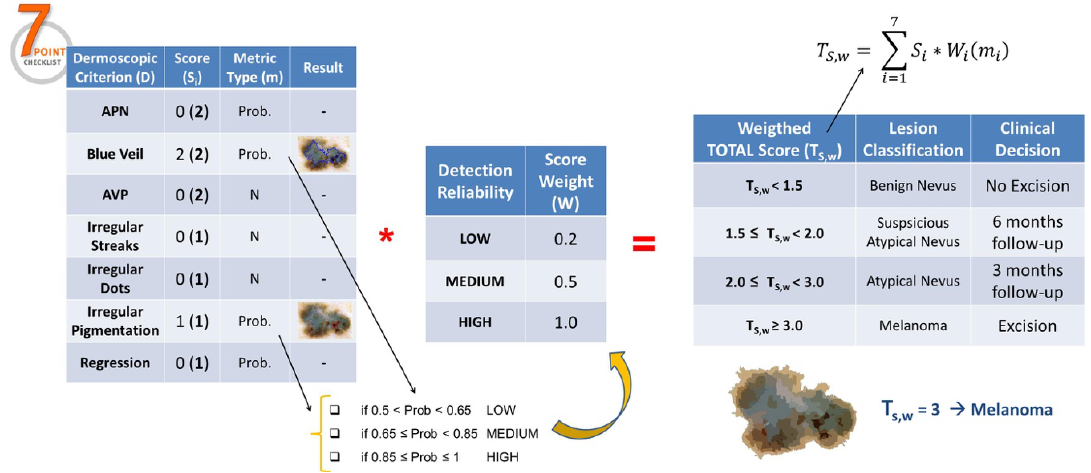
Figure 8. Application of the classification scheme for the clinical decision.